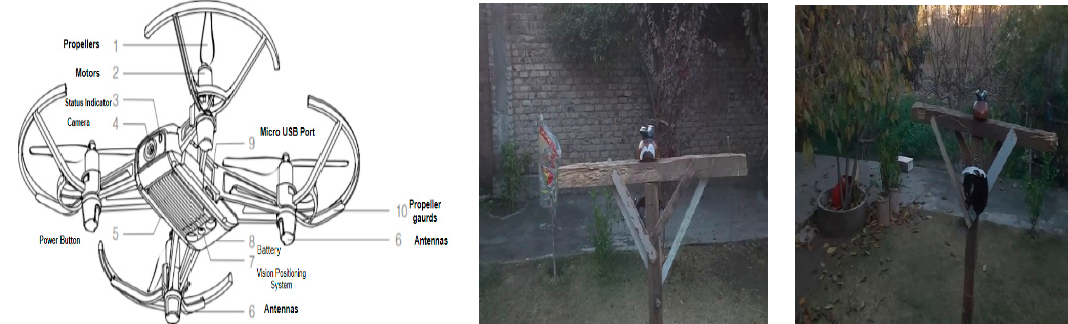
Figure 9. Components of the UAV and the prototype of the electric pole with broken insulators.